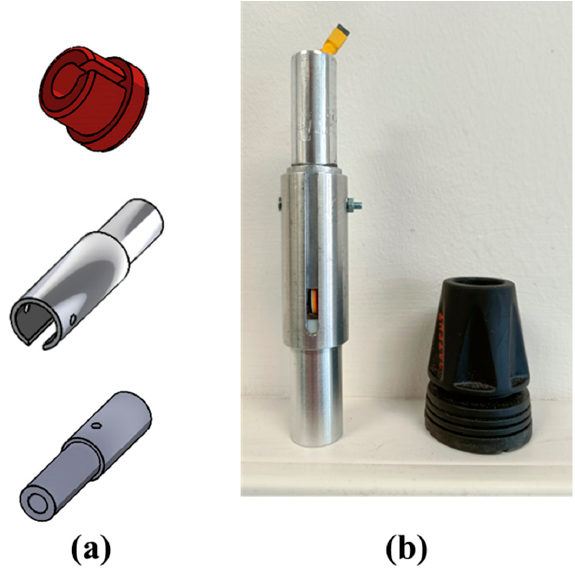
Figure 5. Smart tip structure: ( a ) CAD models and ( b ) fi nished structure.